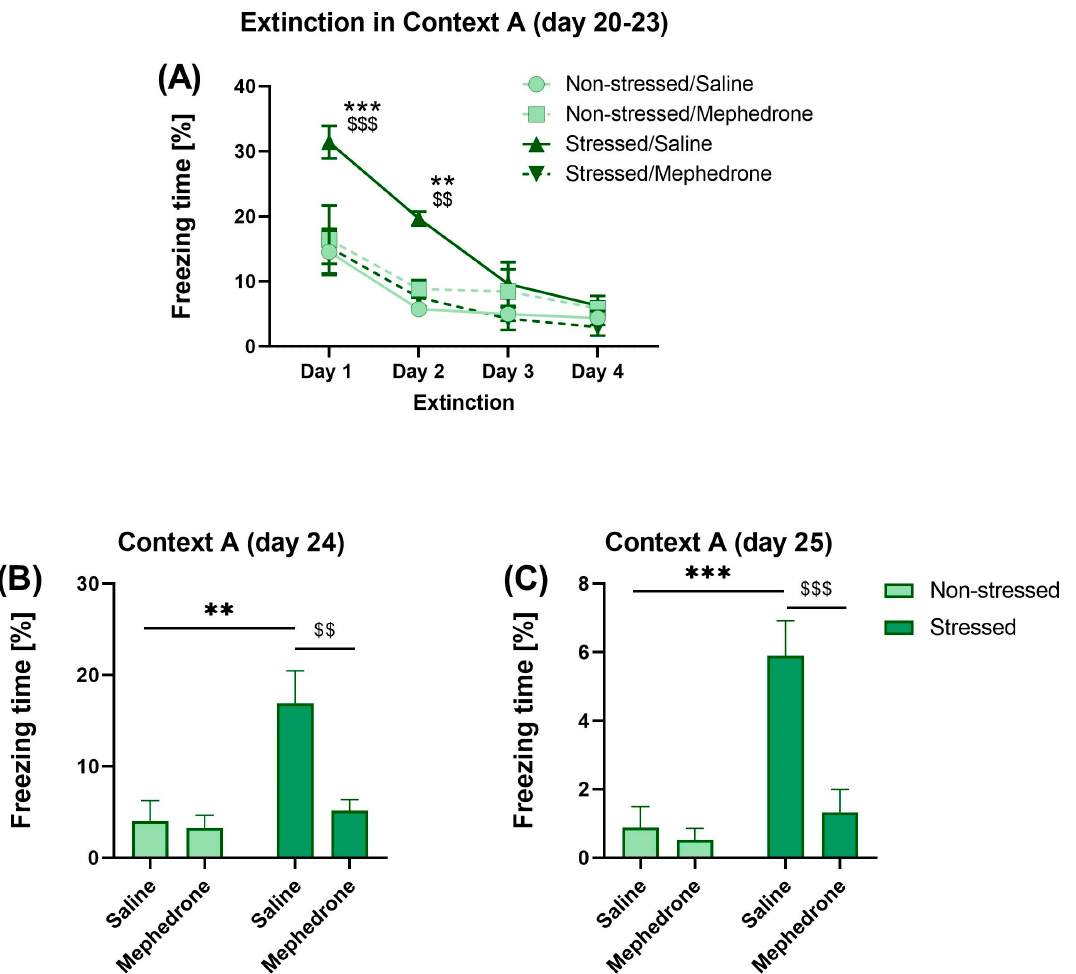
Figure 4. Impact of repeated mephedrone (5 mg/kg) injections on: ( A ) extinction; ( B ) recall (day 24) and ( C ) retention (day 25) of fear memory in PTSD-like model in adolescent rats. Data represent mean ± SEM ( N = 7 rats/group). ** p < 0.01 Non-stressed/Saline vs. Stressed/saline; *** p < 0.001 Non-stressed/Saline vs. Stressed/Saline; $$ p < 0.01 Stressed/Saline vs. Stressed/Mephedrone; $$$ p < 0.001 Stressed/Saline vs. Stressed/Mephedrone.